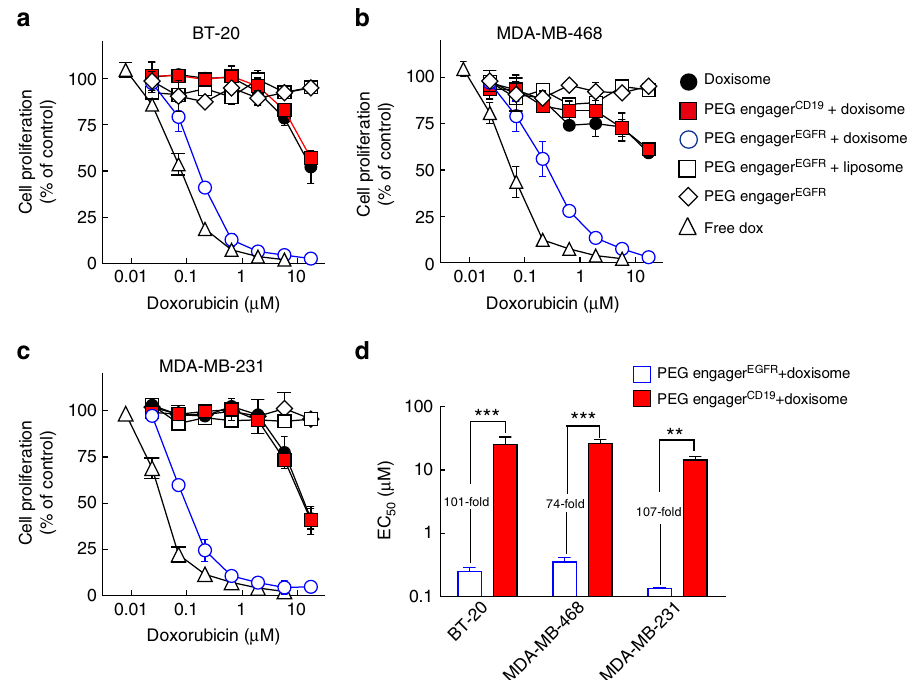
Figure 5 | PEG engager EGFR enhances nanomedicine anti-proliferative activity. BT-20 ( a ), MDA-MB-468 ( b ) and MDA-MB-231 cells ( c ) were incubated with PEG engager EGFR for 30min followed by addition of serial dilutions of Doxisome (white circles) or empty liposomes (white squares) in triplicate for 4h. The cells were also incubated with culture medium or PEG engager CD19 for 30min followed by addition of serial dilutions of Doxisome (black circles and red squares, respectively). Serial dilutions of free doxorubicin (white triangles) or PEG engager EGFR alone (white diamonds) were also added to cells for 4h. The incorporation of 3 H-thymidine into cellular DNA was measured 72h later. The data are representative of three independent experiments. ( d ) The half maximal effective concentration (EC 50 ) values of BT-20, MDA-MB-468 and MDA-MB-231 cells treated with PEG engager CD19 plus Doxisome or PEG engager EGFR plus Doxisome were analysed ( n ¼ 3). Data are shown as mean ± s.d. Significant differences in mean EC 50 values are indicated: ** P r 0.001, *** P r 0.0001 (two-way analysis of